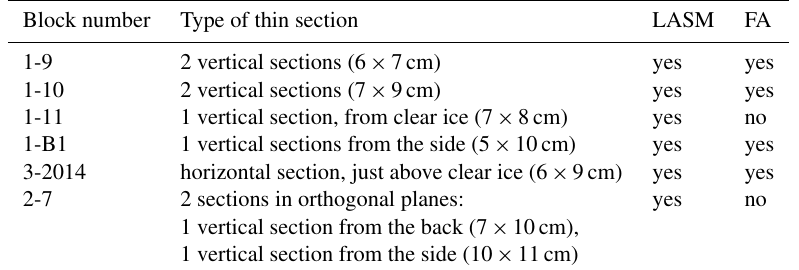
Table 3. Overview of measurements of physical properties of ice samples from Chli Titlis. Indicated are sample and measurement type, i.e., using a large-area scanning macroscope (LASM) and fabric analyzer